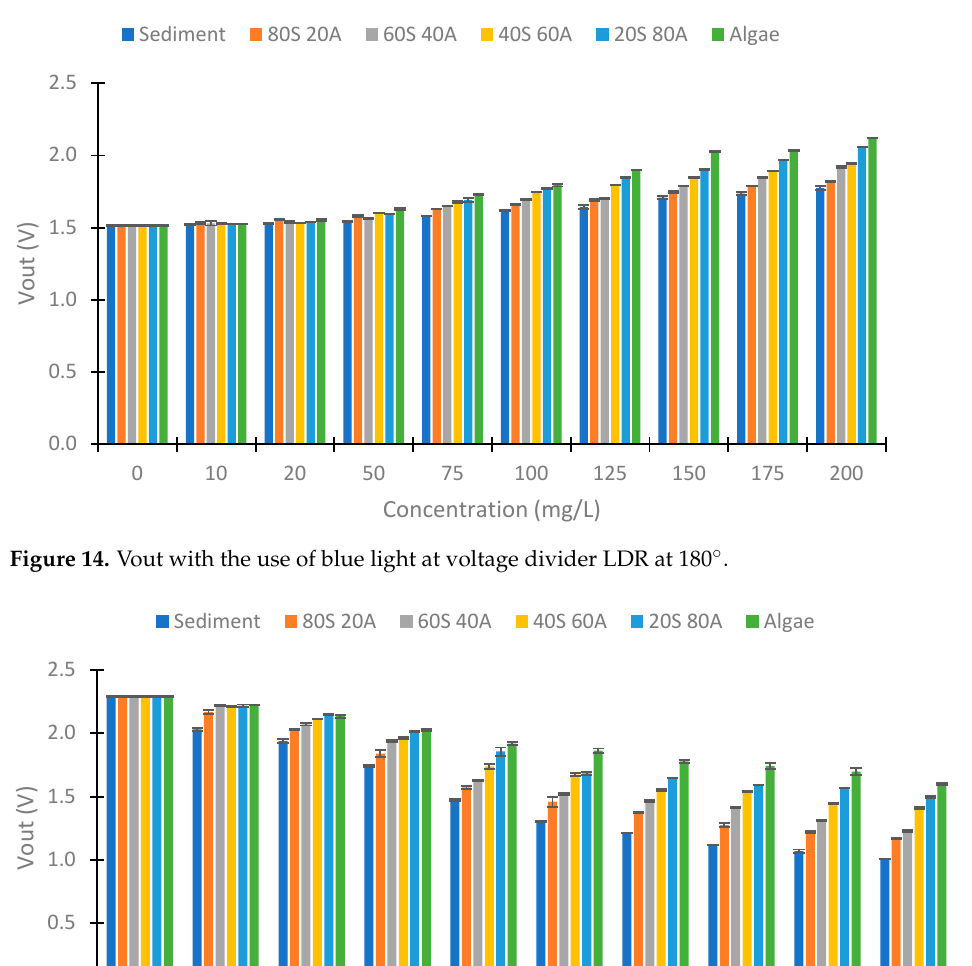
Figure 13. Vout with the use of green light at voltage divider LDR at 180°.